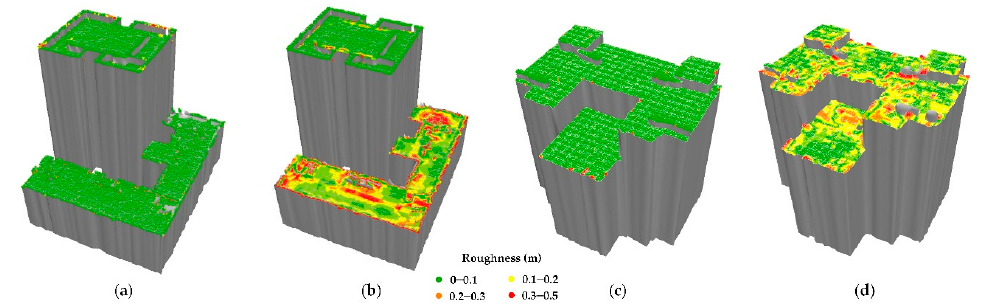
Table 7. Roughness comparison of building roof models for Approaches A and B.